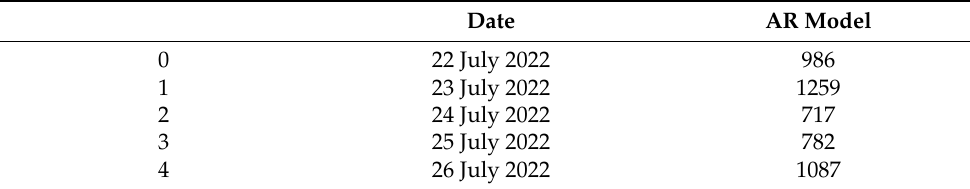
Table 5. AR model confirmed case prediction over five days.